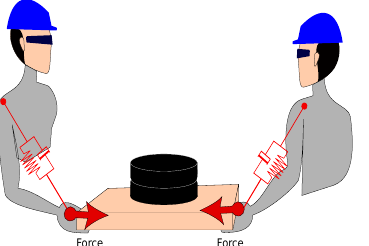
Figure 1. Human-human co-manipulation